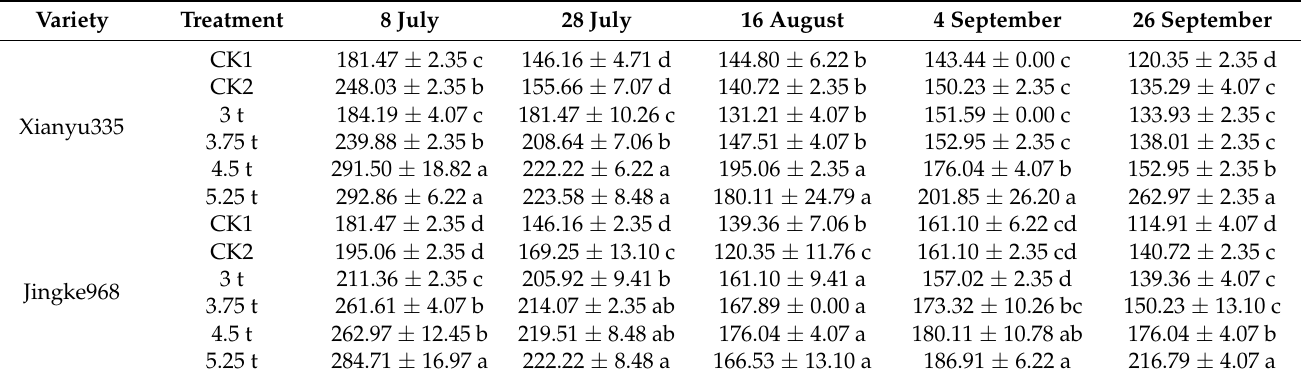
Table 5. Effects of carbon-based fertilizer on soil available potassium content